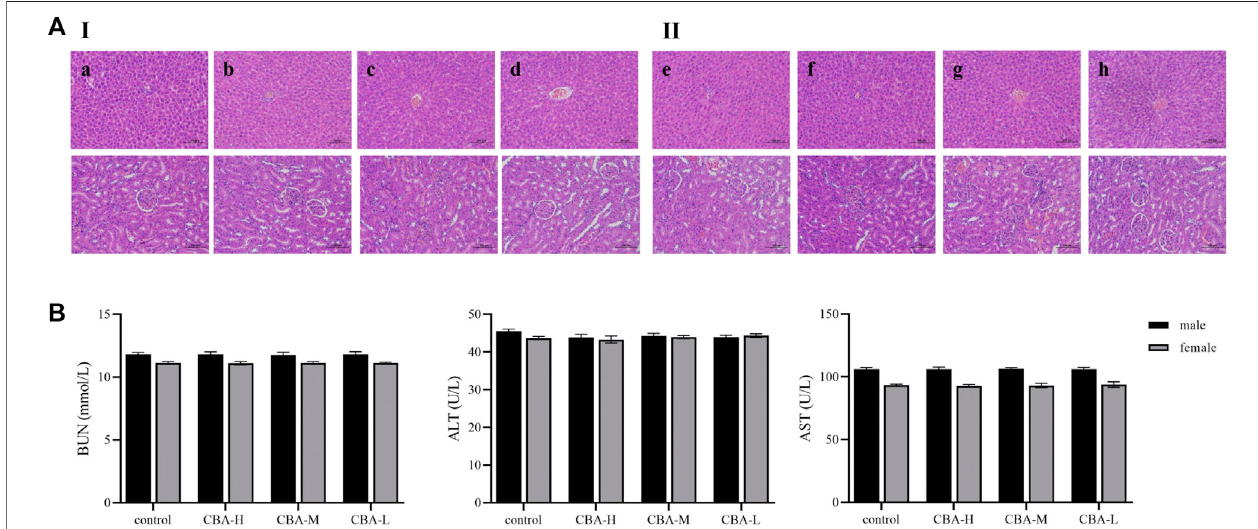
FIGURE 1| Toxicity evaluation of different concentrations of CBA after oral administration in rats. (A) The pathological changes of the liver and kidney in rats by HE staining: (I) male rats: (a) control, (b) CBA-H, (c) CBA-M, (d) CBA-L; (II) female rats: (e) control, (f) CBA-H, (g) CBA-M, (h) CBA-L. (B) Contents of BUN, ALT, and AST in rat